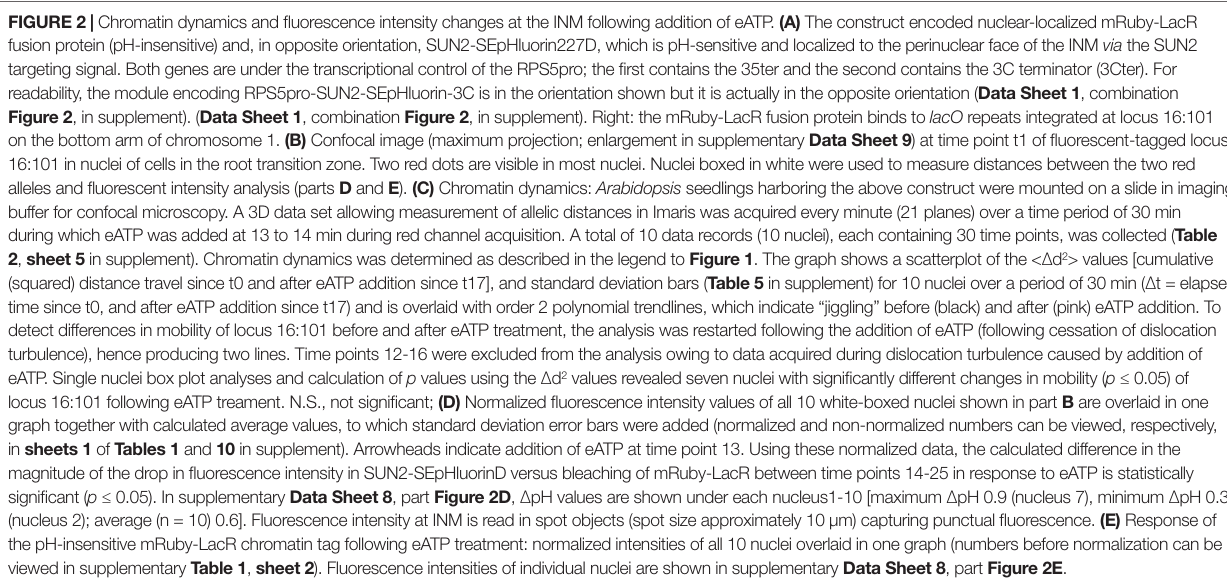
FIGURE 2 | Chromatin dynamics and fluorescence intensity changes at the IN﻿ following addition of eATP. (A) The construct encoded nuclear-localized mRuby-LacR fusion protein (pH-insensitive) and, in opposite orientation, SUN2-SEpHluorin227D, which is pH-sensitive and localized to the perinuclear face of the IN﻿ via the SUN2 targeting signal. Both genes are under the transcriptional control of the RPS5pro; the first contains the 35ter and the second contains the 3C terminator (3Cter). For readability, the module encoding RPS5pro-SUN2-SEpHluorin-3C is in the orientation shown but it is actually in the opposite orientation ( Data Sheet 1 , combination Figure 2 , in supplement). ( Data Sheet 1 , combination Figure 2 , in supplement). Right: the mRuby-LacR fusion protein binds to lacO repeats integrated at locus 16:101 on the bottom arm of chromosome 1. (B) Confocal image (maximum projection; enlargement in supplementary Data Sheet 9 ) at time point t1 of fluorescent-tagged locus 16:101 in nuclei of cells in the root transition zone. Two red dots are visible in most nuclei. Nuclei boxed in white were used to measure distances between the two red alleles and fluorescent intensity analysis (parts D and E ). (C) Chromatin dynamics: Arabidopsis seedlings harboring the above construct were mounted on a slide in